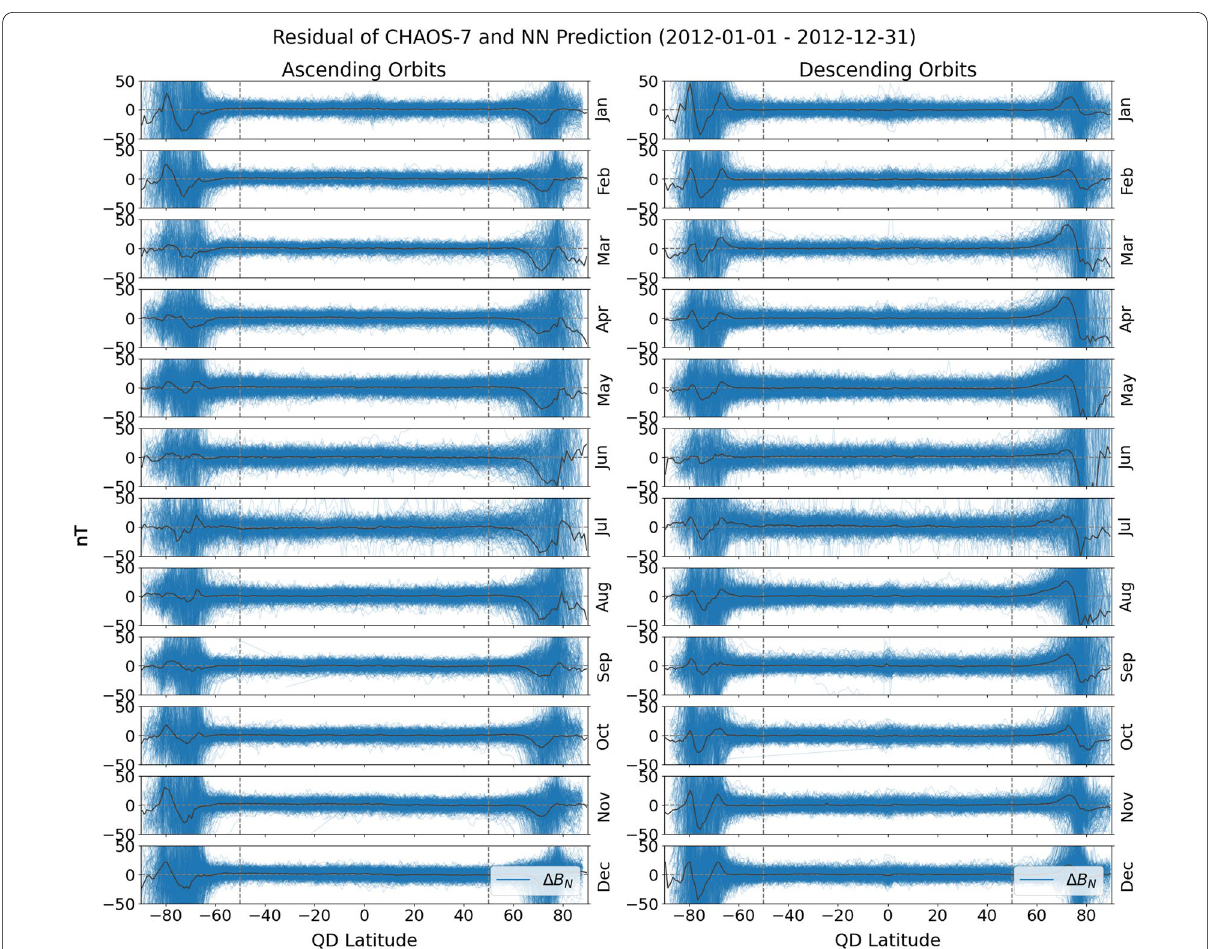
Fig. 4 Residual between the calibrated platform magnetometers and the CHAOS‑7 reference model as a function of the quasi‑dipole latitude (QDLAT) for every month of the year 2012 of the North component of the calibrated measurement in nT. The orbits are split into the ascending dusk‑orbits on the left, and the descending dawn‑orbits on the right, with the mean residual depicted in